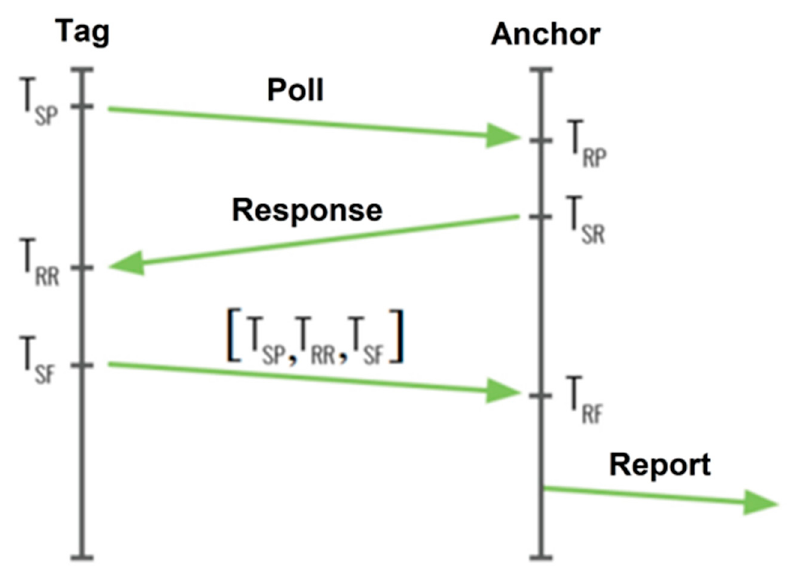
Figure 2. UWB Tag-Anchor communication diagram.